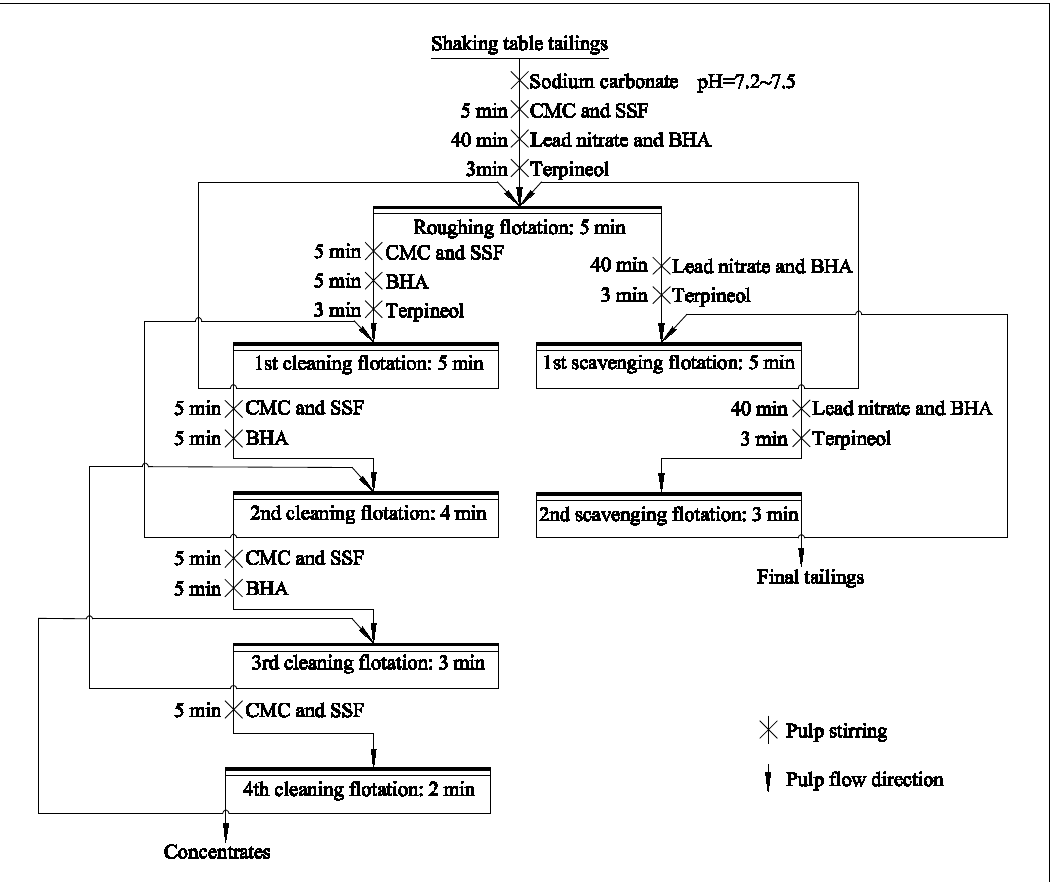
Figure 9. The bench-scale closed circuit flotation flowchart of the shaking table tailings.